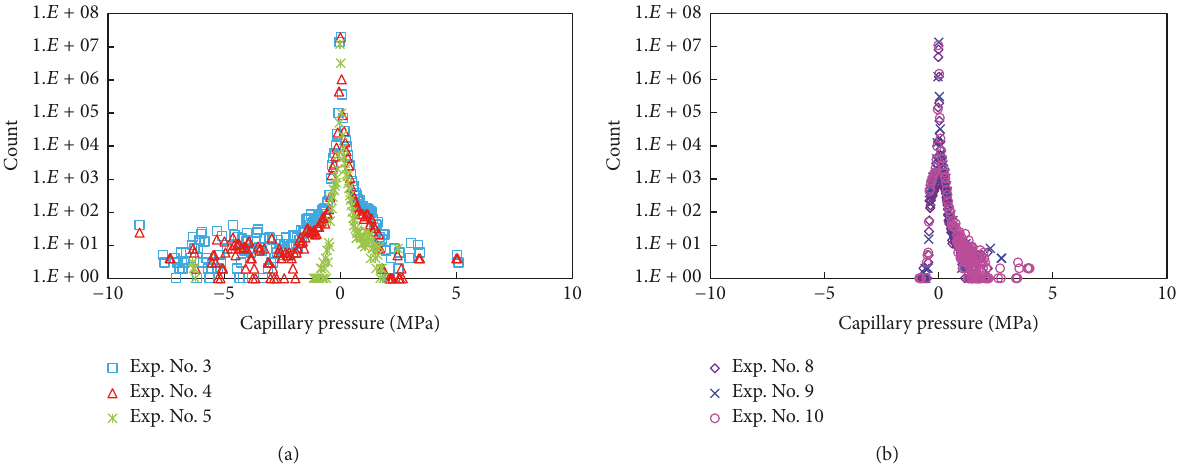
Figure 15: Capillary pressure distributions of oil in water-wet (a) and oil-wet (b) plug during the plug-flood